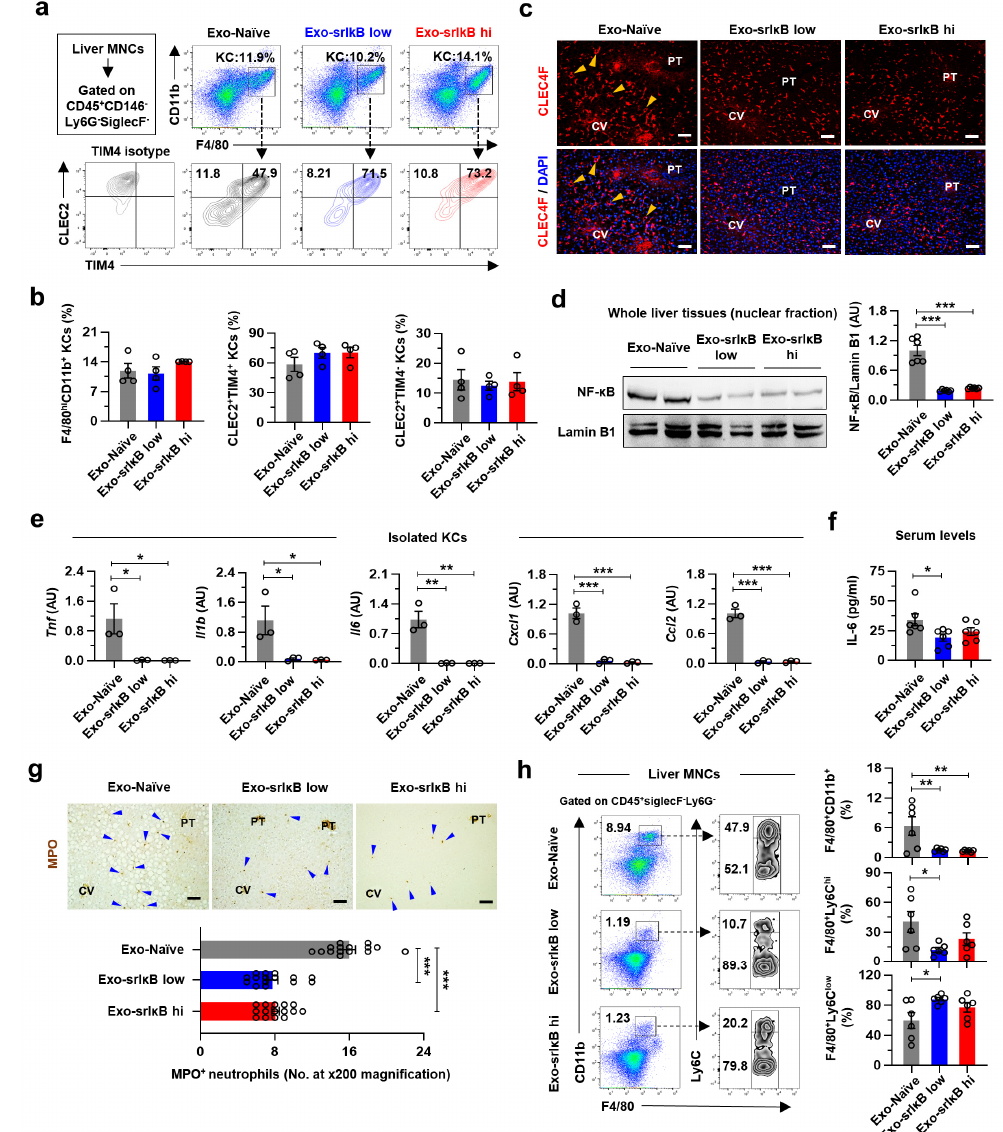
Figure 6. Three consecutive days of Exo-srI κ B injection attenuates alcohol-associated hepatic inflam- mation by suppressing the activation of KCs in mice. ( a – h ) WT male mice were fed EtOH for nine days and randomly divided into Exo-Naïve, low dose of Exo-srI κ B, or high dose of Exo-srI κ B groups ( n = 6 per group). An indicated dose of exosomes was intravenously injected every 24 hours for consecutive 3 days. After 6 h of the last injection, mice were given acute EtOH binge drinking (4 g kg − 1 of 40% EtOH gavage) and sacrificed after 6 h. ( a , b ) Flow cytometry analyses of F4/80 hi CD11b + KCs with C-type lectin-like receptor 2 (CLEC2) and T-cell immunoglobulin and mucin domain containing 4 (TIM4). Representative panels ( a ) with bar graphs ( b ) ( n = 4 per group). ( c ) Representative C-type lectin domain family 4 member F (CLEC4F) immunostaining of liver tissues. Morphological changes in CLEC4F + KCs were indicated by yellow triangles. ( d ) Representative Western blot analyses of hepatic nuclear fraction (two blots/group) and densitometry analysis ( n = 6 per group). ( e ) qRT-PCR analyses of isolated KCs ( n = 3 per group). ( f ) Serum IL-6 levels were measured. ( g ) Representative myeloperoxidase (MPO) immunostaining of liver tissues ( upper ). MPO + neutrophils were indicated by blue triangles and counted in 15 random images at × 200 magnification ( lower ). ( h ) Flow cy- tometry analyses of liver MNCs with representative panels and bar graphs. Data are presented as mean ± SEM. * p < 0.05, ** p < 0.01, *** p < 0.001. Data were analyzed by a one-way ANOVA with Tukey’s multiple comparisons test. Scale bars, 50 µ